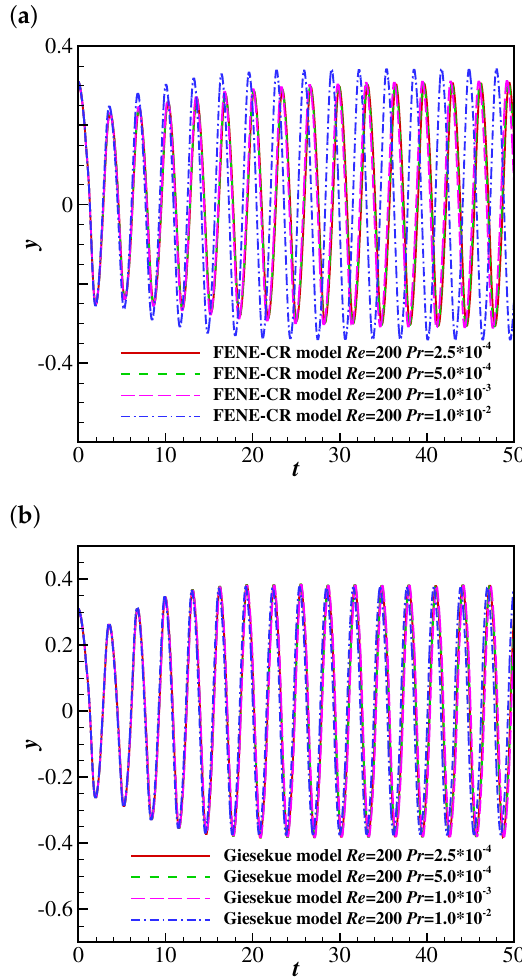
Figure 6. The time histories of the free-end position of the filament at Re = 200 and Wi = 1.0 in the ( a ) FENE-CR and ( b ) Giesekus fluids at different values of Pr